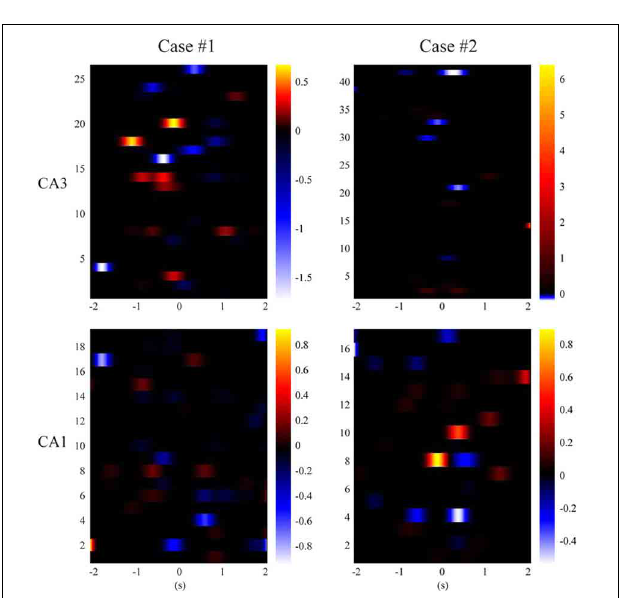
FIGURE 9 | Sparse classification feature matrices of the MISO memory decoding models (case #1 and #2). Black color represents zero-valued